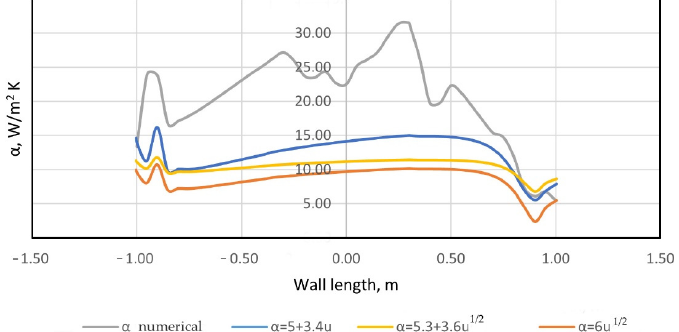
Figure 20. Heat transfer coefficients for the left wall 𝛼 𝑖𝑛 .